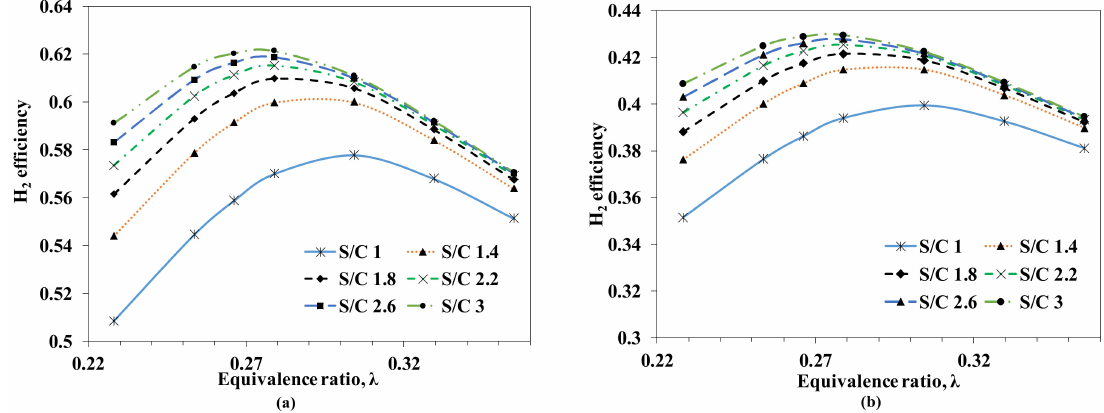
Figure 6. Hydrogen efficiency for different equivalence ratios and S/C ratios for the PAPS processes. For the base case, ATR and shifting occur at 1 bar and H 2 recovery is carried out at 10 bar. ( a ) Using bio-oil (LHV 16.6 MJ/kg) as starting material (Equation (5)). ( b ) Using wet PEFB (40% moisture, LHV 11.0 MJ/kg) as starting material (Equation (6)).